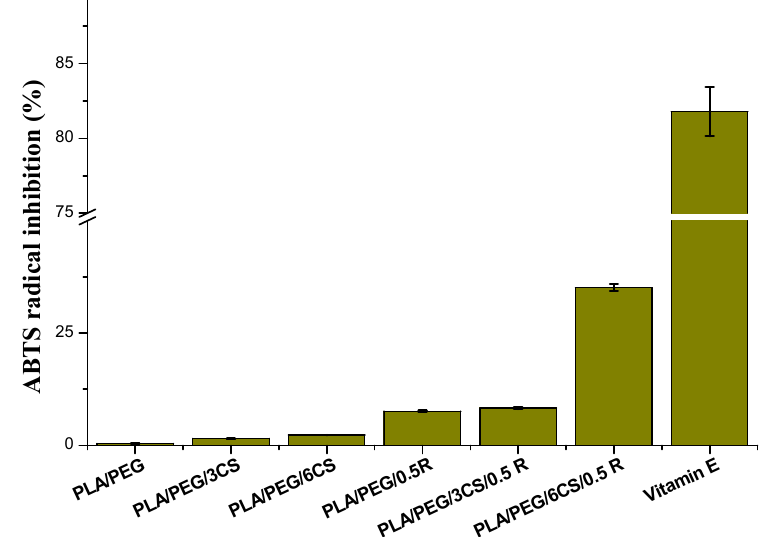
Figure 6. ABTS • + radical inhibition activity of the PEG-plasticized PLA containing chitosan and powdered rosemary ethanolic extract.